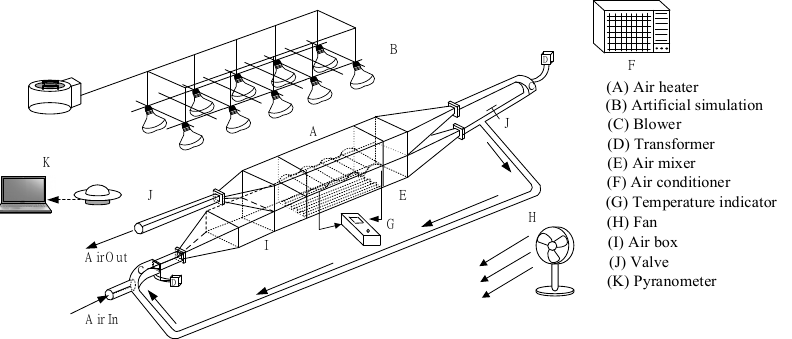
Figure 7. Experimental setup of a recycling cross-corrugated solar air collector ( Type A ).